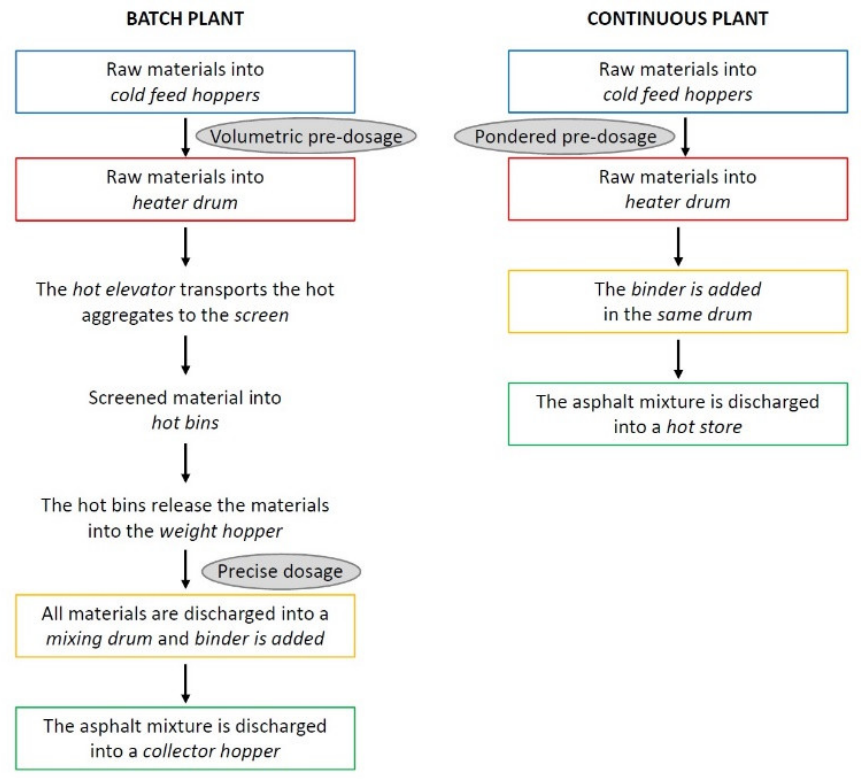
Figure 1. Operational procedures of batch and continuous plants.